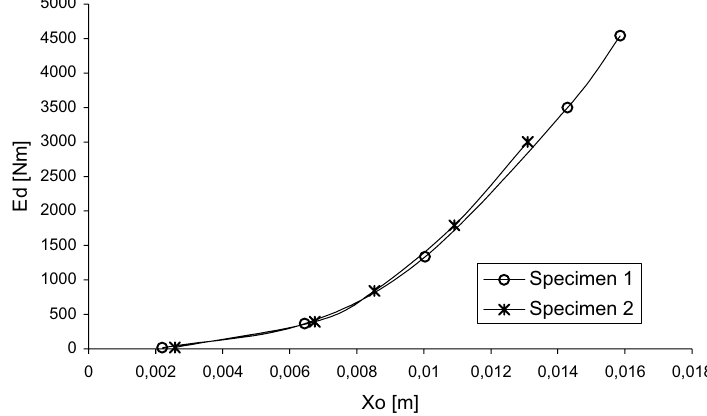
Fig. 6. Dissipated energy per cycle of oscillation with respect to excitation amplitude